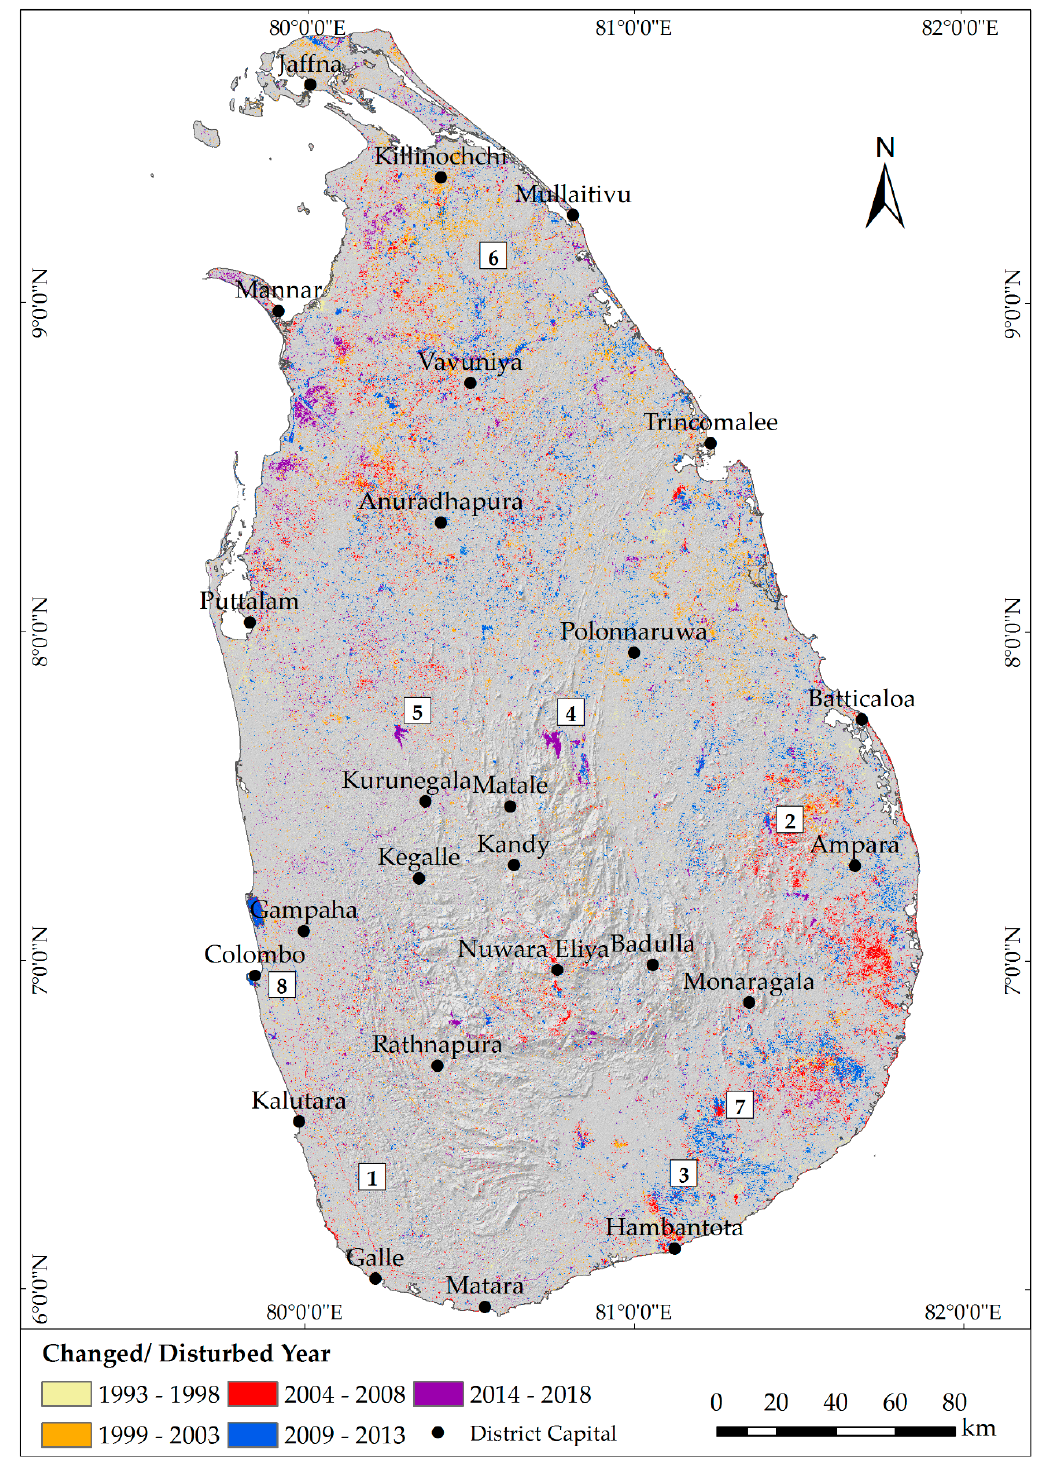
Figure 7. Distribution of land cover changes and / or disturbances by defined periods (1993 to 2018). The numbers refer to examples of land cover diversification projects that occurred during the study period: 1. The southern expressway (the first highway in Sri Lanka) and the railway line, 2.